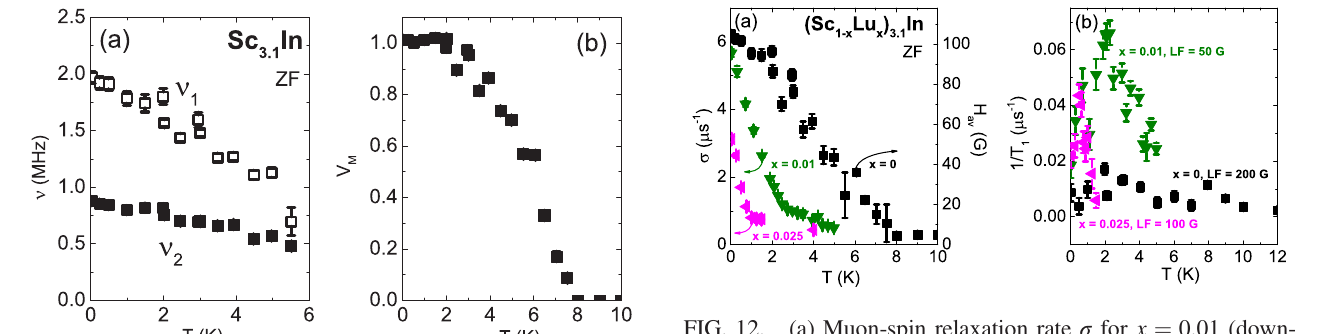
FIG. 12. (a) Muon-spin relaxation rate σ for x ¼ 0 . 01 (down- ward-facing triangles) and x ¼ 0 . 025 (leftward-facing triangles) Þ for ð Sc 1 − Lu 3 . 1 In (left axis), along with the average static x x internal field H for x ¼ 0 (right axis), obtained from the fits of av ZF μ SR measurements. The vertical axes are scaled with γ μ , the gyromagnetic ratio of a positive muon. (b) The longitudinal relaxation rate 1 =T 1 , obtained from the LF μ SR